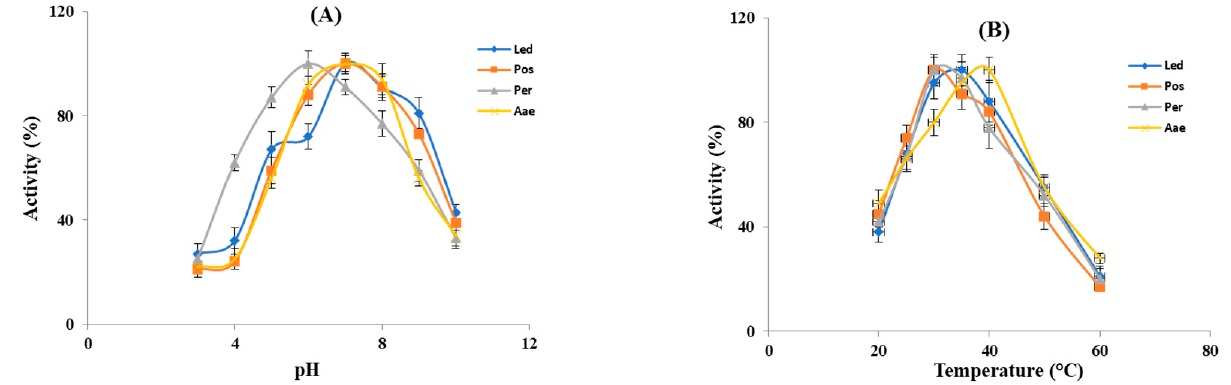
Figure 3. Effect of pH and temperature on the fibrin(ogen)olytic enzymes. ( A ) Optimal pH for the enzyme activity of crude extracts was evaluated within a pH range of 3–10 at 37 °C. ( B ) Optimal temperature for the enzyme activity of crude extracts was determined within a temperature range of 20–60 °C. Led: L. edodes , Pos: P. ostreatus , Per: P. eryngii , Aae: A. aegerita .